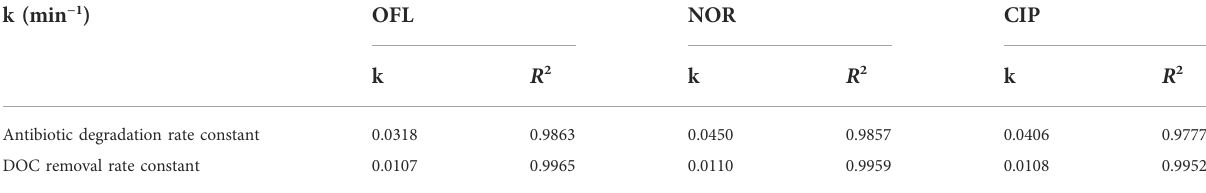
TABLE 2 Photocatalytic degradation rate constants and DOC removal rate constants of 10% IGCN during OFL, NOR, and CIP degradation. k (min − 1